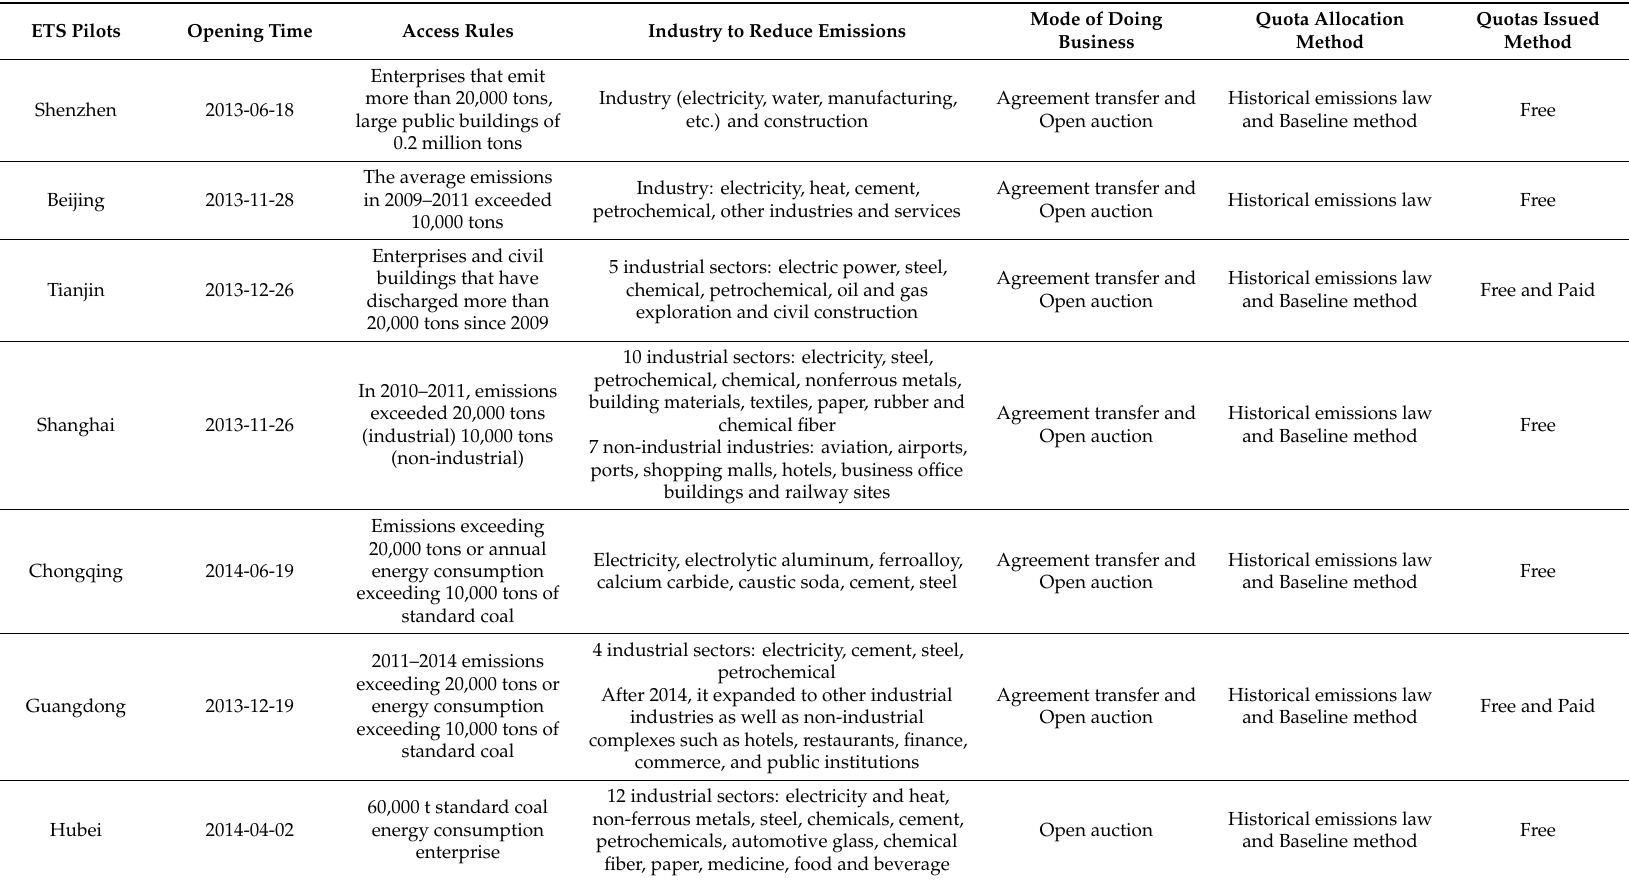
Table 1. Overview of the rules of ETS markets in the